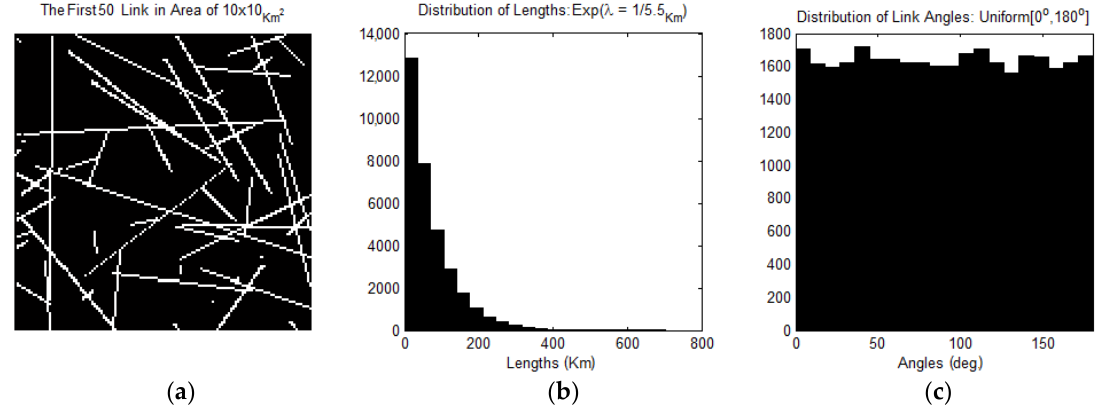
Figure 7. Portraying the main attributes of the synthetic CMLs. ( a ) spatial distribution, ( b ) lengths distribution, ( c ) angles distributions [6]. distribution, ( c ) angles distributions